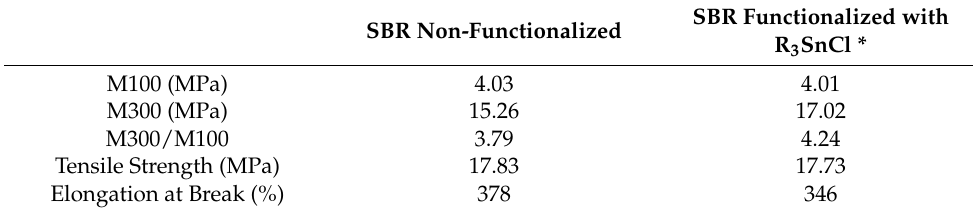
Table 6. Effects of Tin Chain-End functionalization of SBR in CB-Filled Rubber [101]. SBR